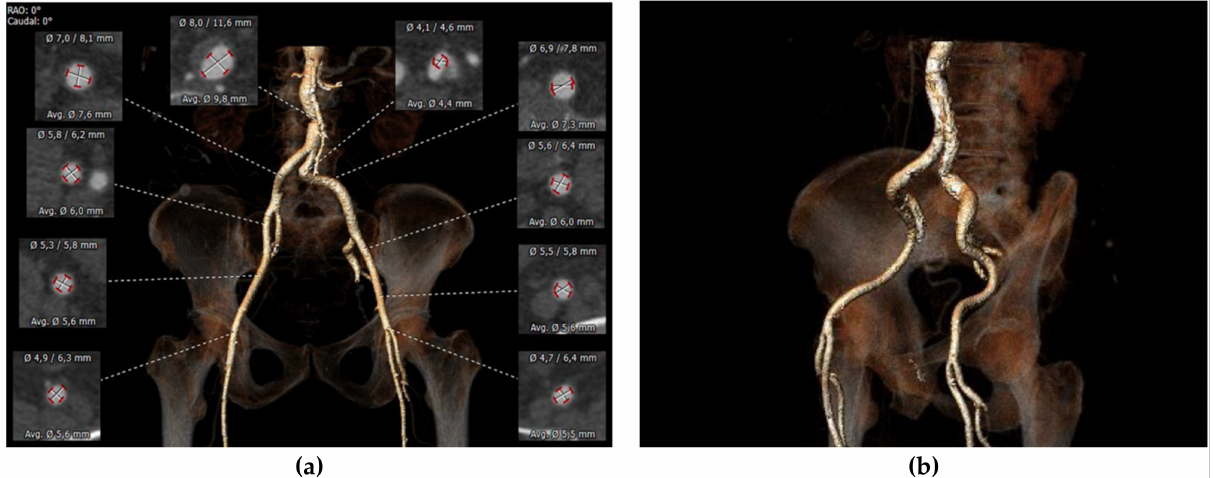
Figure 2. ( a ) Preoperative measurements of peripheral accesses for TAVI feasibility. ( b ) Preoperative femoral and iliac courses